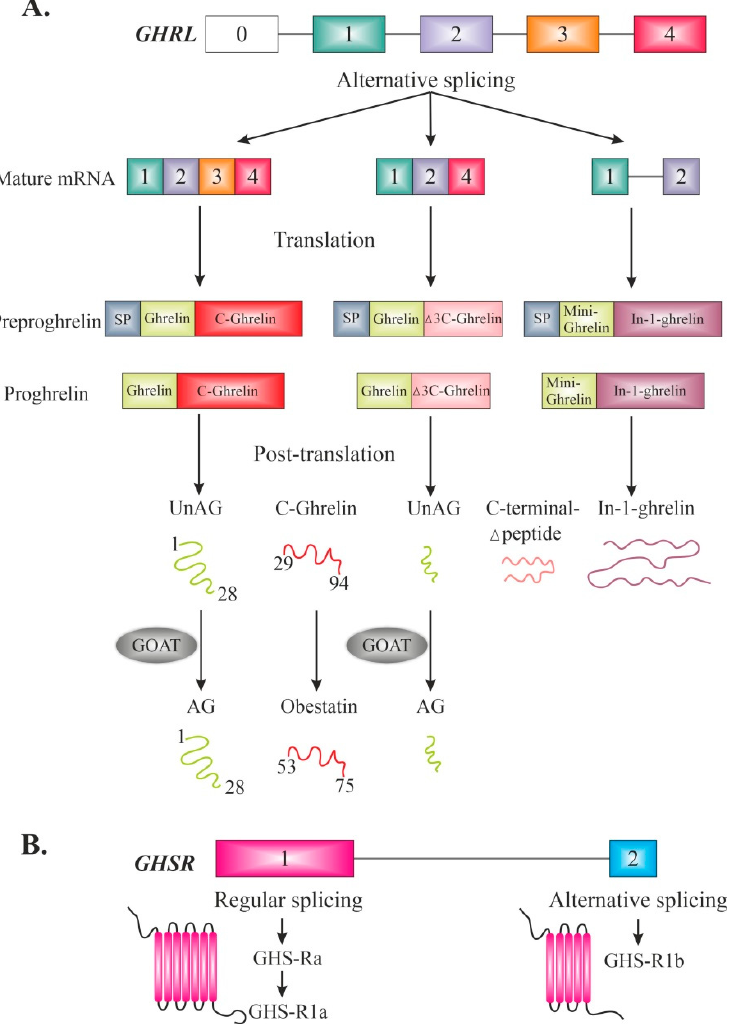
Figure 1. Schematic diagram of the genes encoding human ghrelin ( GHRL ) ( A ) and the ghrelin receptor ( GHSR ) ( B ). The functionally relevant GHRL and GHRS gene-derived transcripts and the most important peptides are specified. Exons are marked as boxes, and introns as lines. [AG-acylated ghrelin; GOAT-ghrelin-O-acyltransferase; SP-Signal peptide; UnAG-unacylated ghrelin].